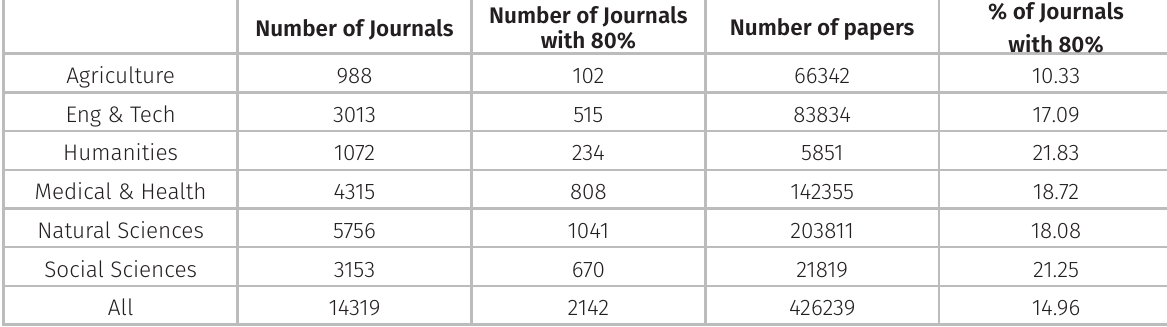
Table I. Summary of publication distribution by Brazilian authors (Incites ®